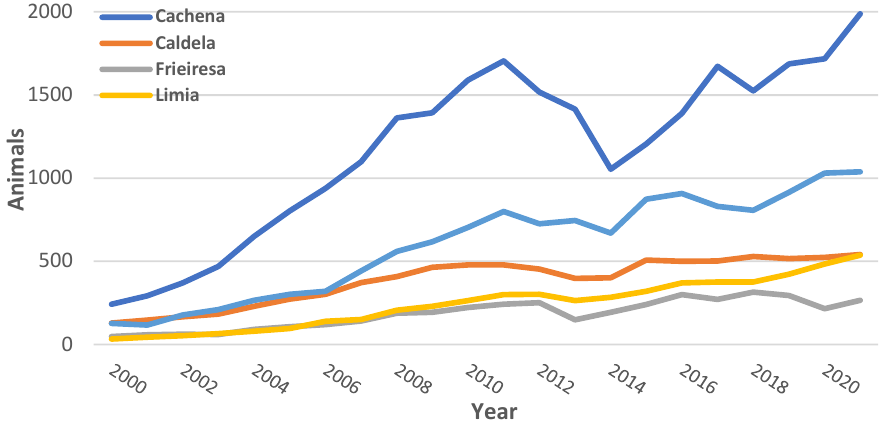
Figure 2. Census evolution of the five Galician bovine breeds.